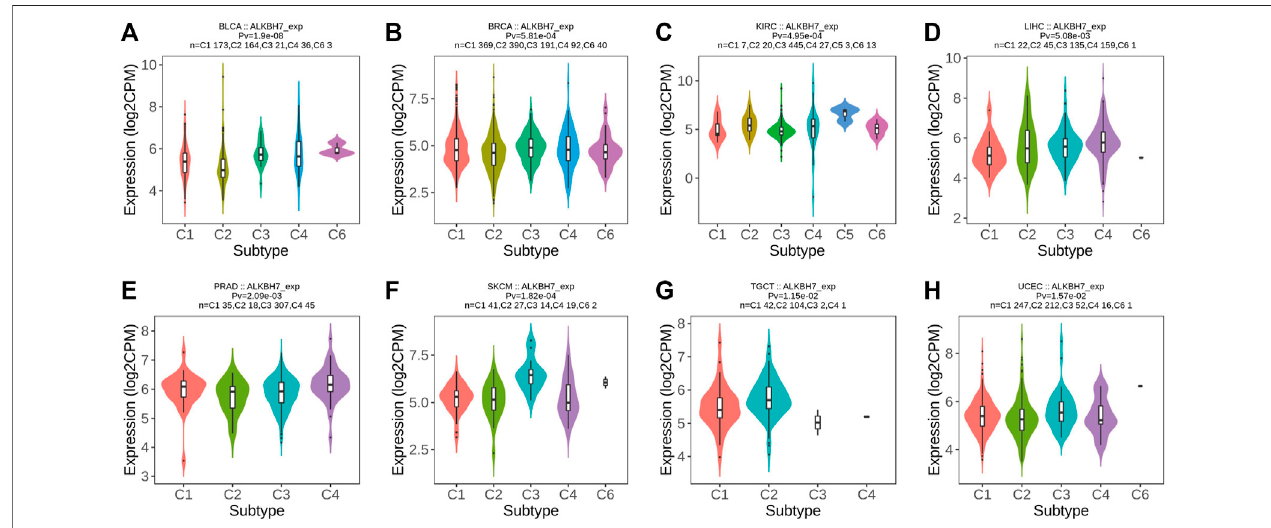
FIGURE6| TherelationshipbetweenALKBH7expressionandimmunesubtypesinBLCA (A) ,BRCA (B) ,KIRC (C) ,LIHC (D) ,PRAD (E) ,SKCM (F) ,TGCT (G) and UCEC (H) . [C1 (wound healing); C2 (IFN-gamma dominant); C3 (in fl ammatory); C4 (lymphocyte depleted); C5 (immunologically quiet); C6 (TGF-beta dominant)].